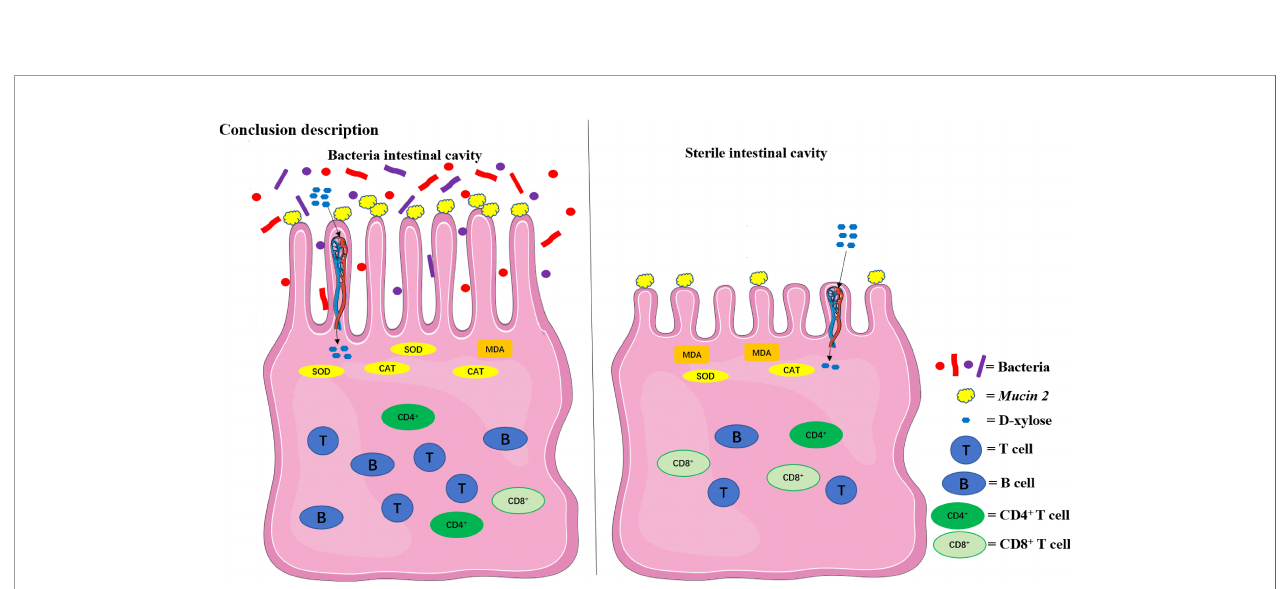
FIGURE 6 | The relationship between the intestinal fl ora and the function of the intestinal physiology in the present study. The intestinal physiology of the chicken with bacteria in the intestine was described on the left and the IBF on the right. FMT reshaped the physiological function of the intestine in IBF chicken. SOD, superoxide dismutase; CAT, catalase; MDA,